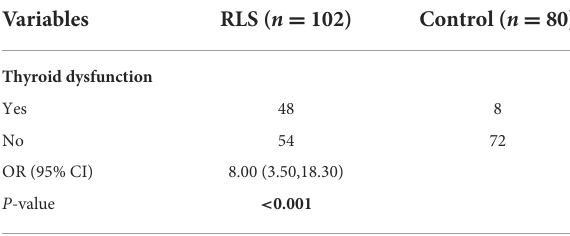
TABLE 2 The prevalence of the thyroid dysfunction in